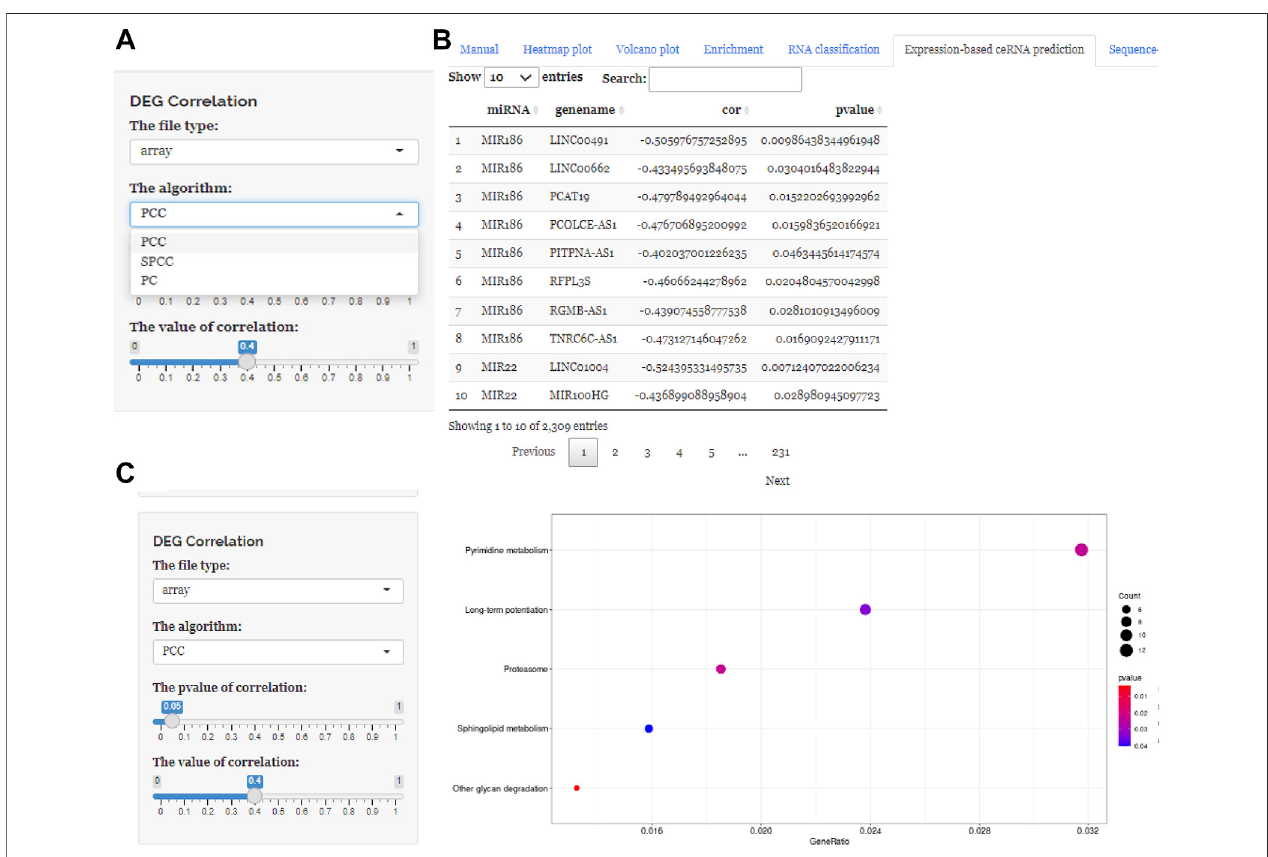
FIGURE 4 | Using ceRNAshiny to generate “ Expression-based ceRNA prediction. ” (A) Panels to show the type of arithmetic and adjust parameters. (B) The generated algorithm prediction and its enrichment results based on PCC, PC, and SPPC arithmetic using the template dataset.